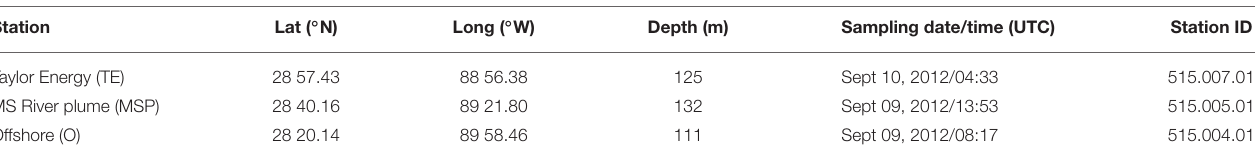
TABLE 1 | Description of sampling sites and dates of